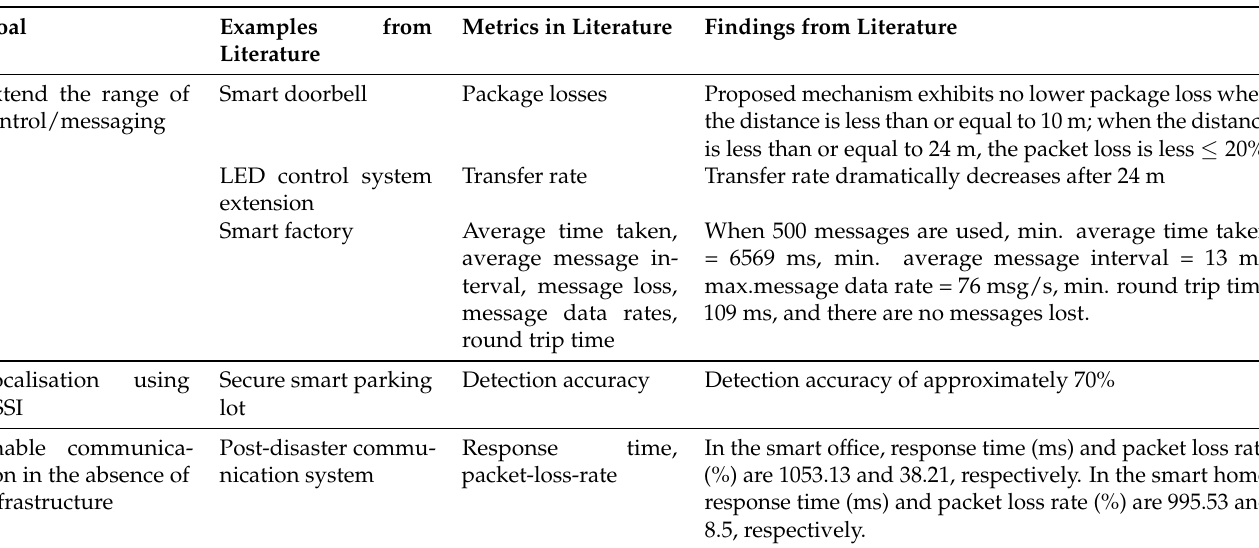
Table 2. Validated Bluetooth Mesh applications discussed in related